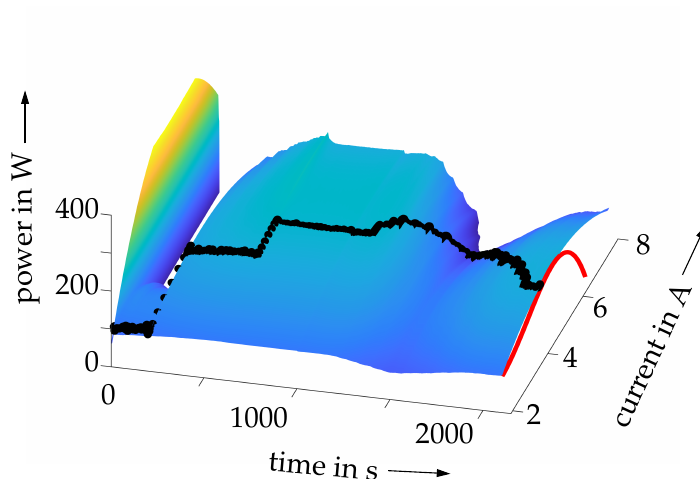
Figure 8. Kalman filter-based online parameter identification for the measured data in Figure 5a–c; black dots represent the power measurements in Figure 5c; the red curve at the final time instant corresponds to the offline identified current–power characteristic in Figure